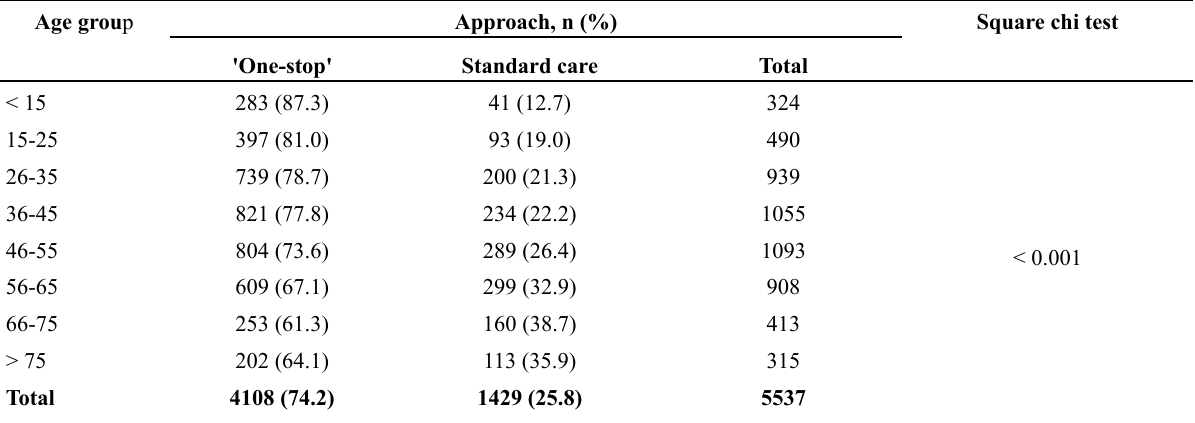
Table 2 - Relationship between age-group and type of approach ('one-stop' or standard care). In parentheses, percent. Age grou